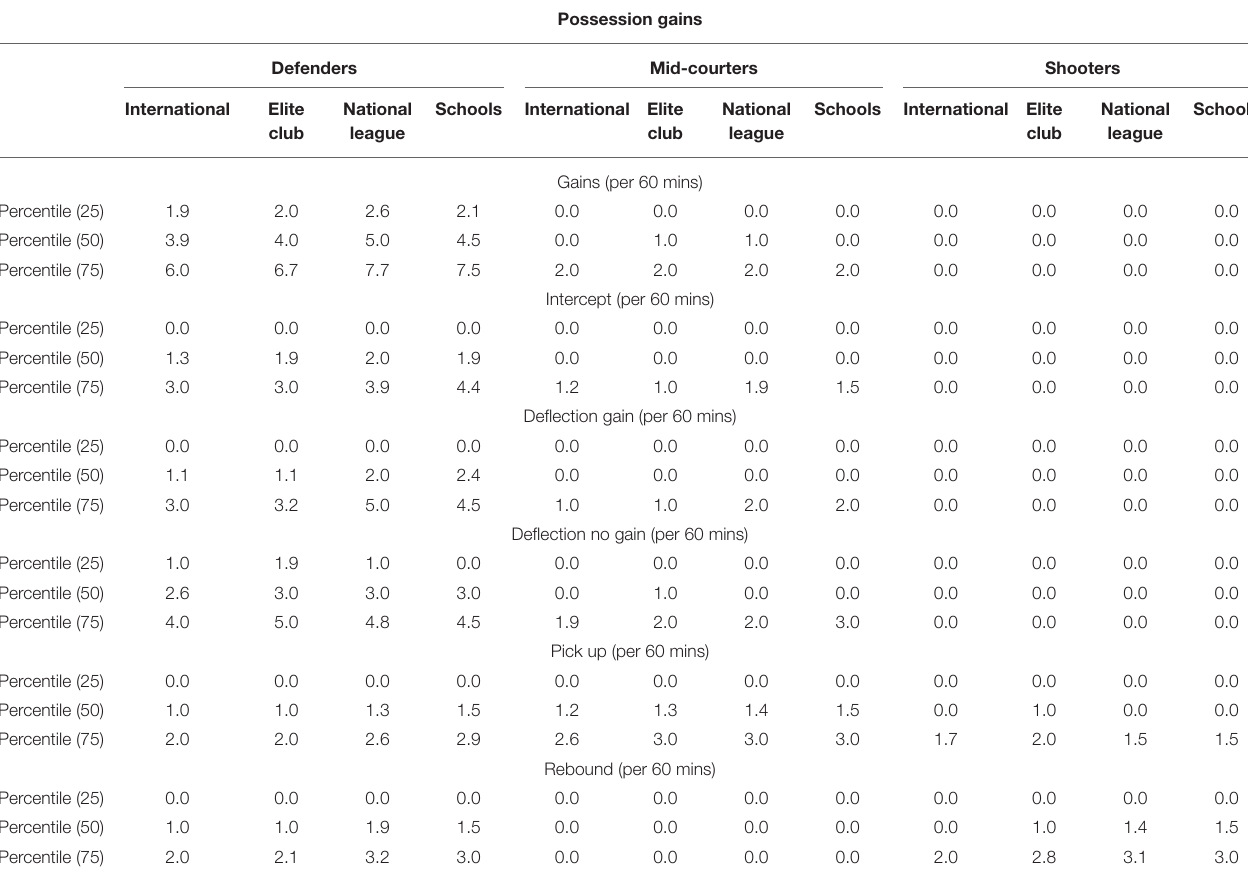
TABLE 2 | Comparison between the various level of netballs normative data for possession gains